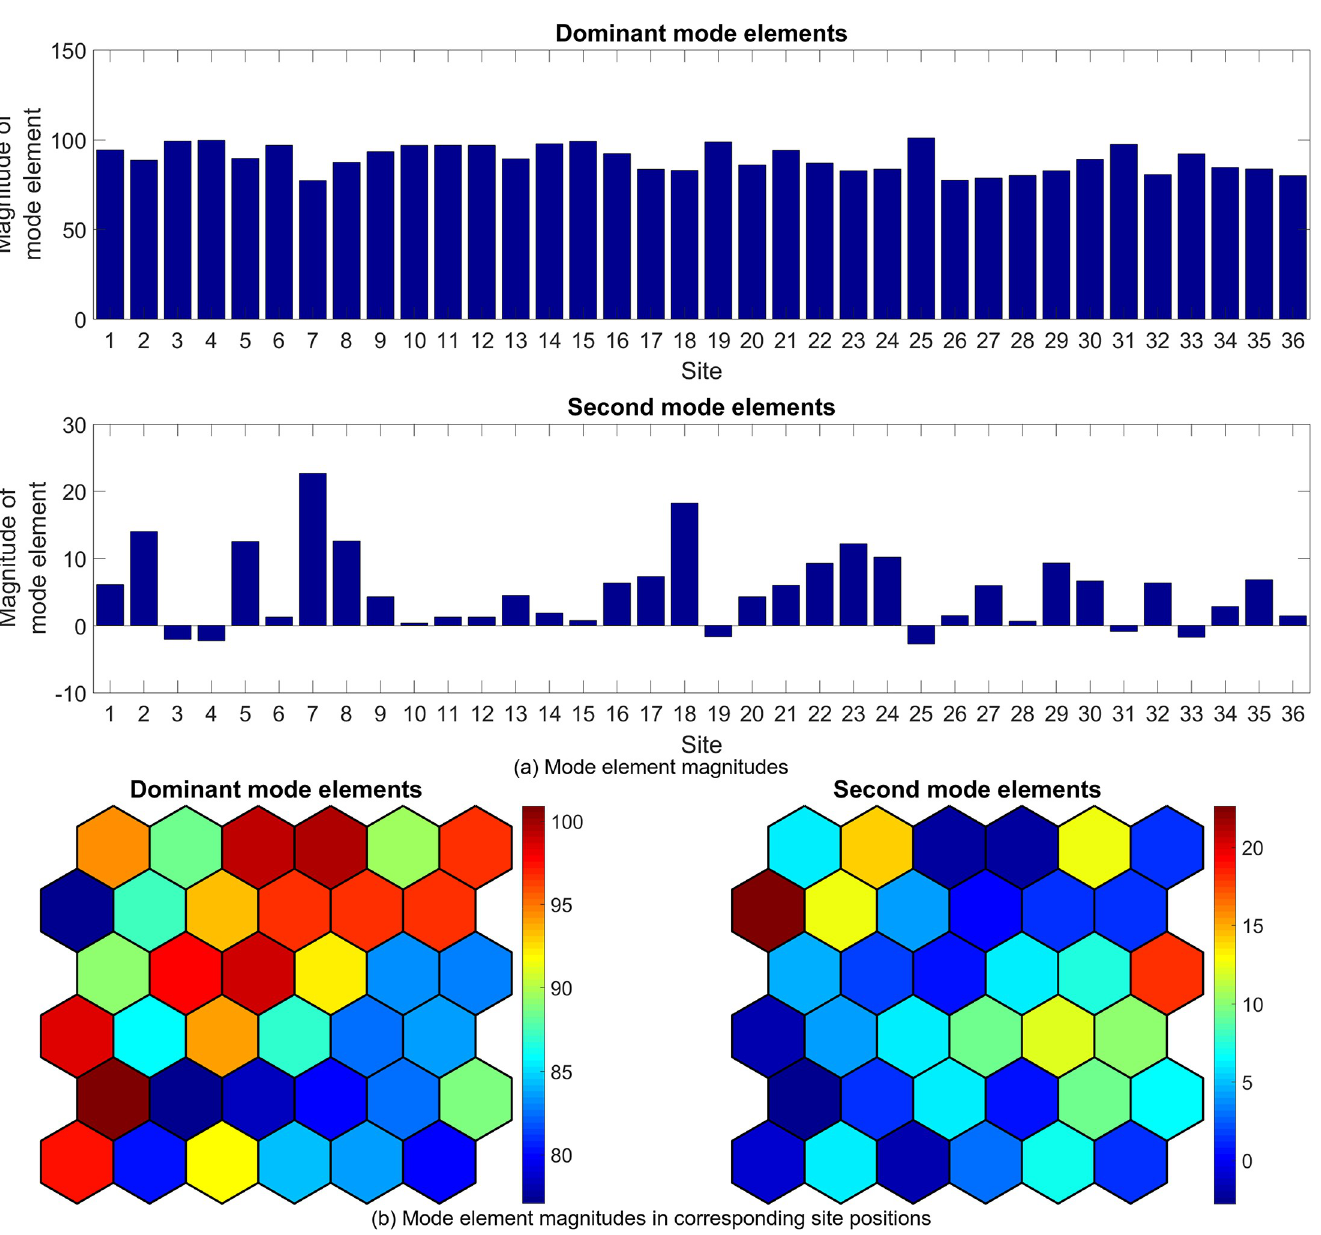
Fig 27. Example mode elements of the dominant and second modes from a single simulation for maximum site fuel value of 200 units, shown in bar graph form (a) and in the spatial positions of the corresponding sites (b). The dominant mode values approximate the mean site fuel values, while the second mode values show the degree to which site fuel values oscillate and/or undergo long-term